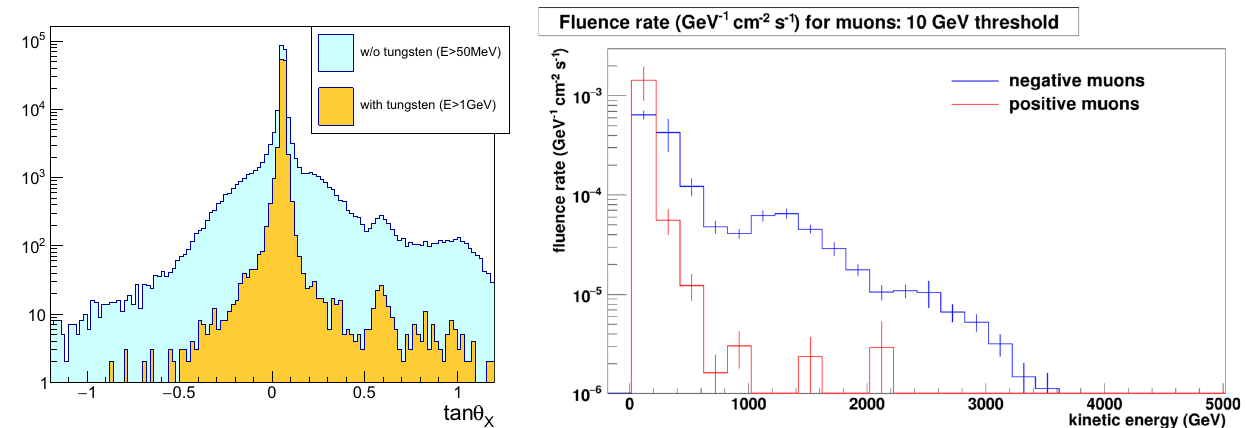
Fig. 13 Left : Angular distributions of charged particles measured by the emulsion films with and without tungsten plates, corresponding to energy cutoffs of about 1 GeV and 50 MeV, due to multiple Coulomb scattering, respectively. Right : Fluxes of positive and negative muons